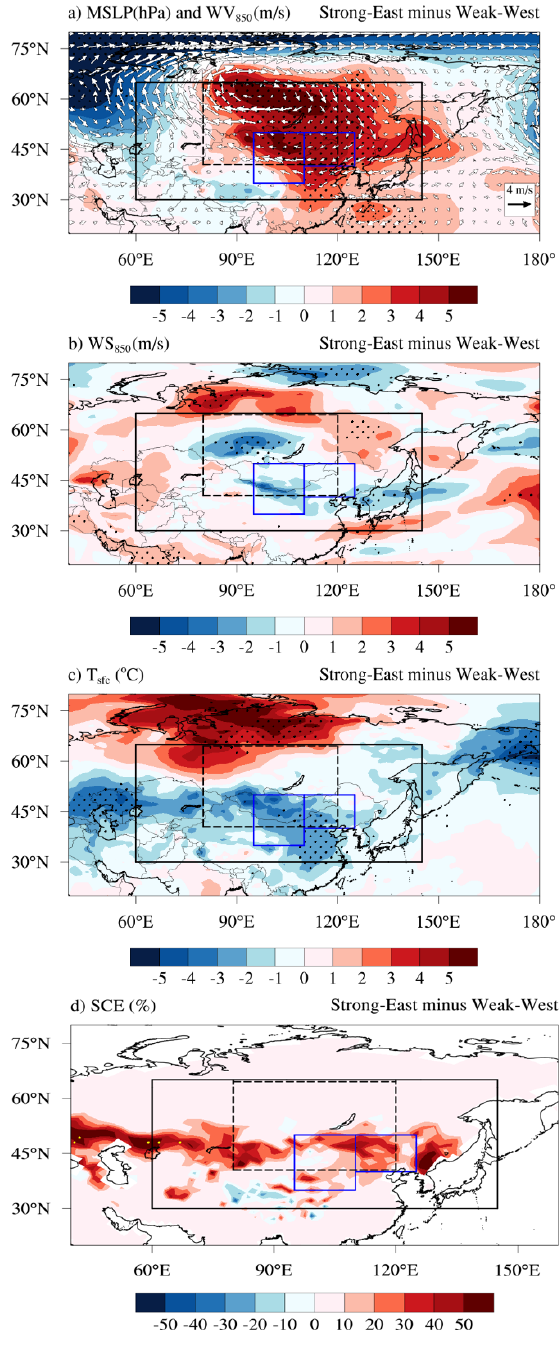
Figure 5. Composite differences in meteorological variables between the Strong-East and Weak-West periods. ( a ) MSLP (shaded; hPa) and WV 850 (white arrows; m s − 1 ), ( b ) WS 850 (shaded; m s − 1 ), ( c ) T sfc (shaded; °C), and ( d ) SCE (shaded; %). Boxes are the same as shown in Figure 1. Black dotted areas (yellow dots in Figure 5d) indicate the differences are statistically significant above the 90% confidence level based on the Student’s t -test.